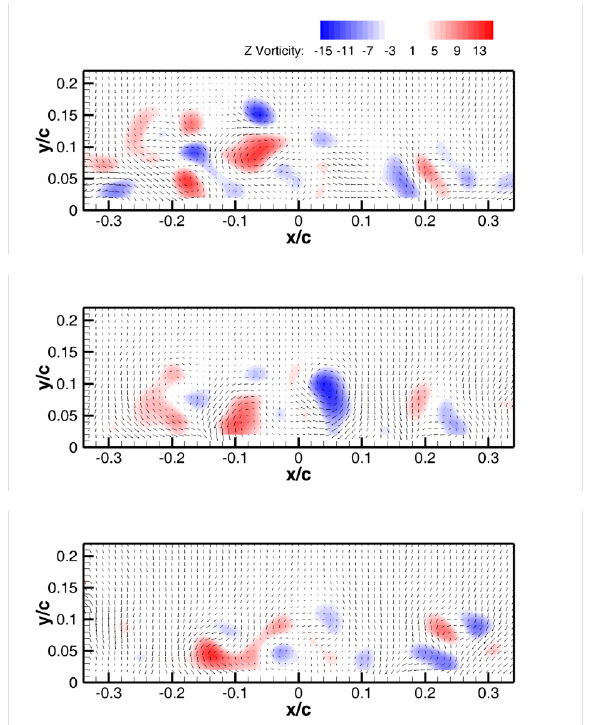
Fig. 6. Instantaneous velocity vectors with vorticity distributions, measuring plane 1 (3 examples) .